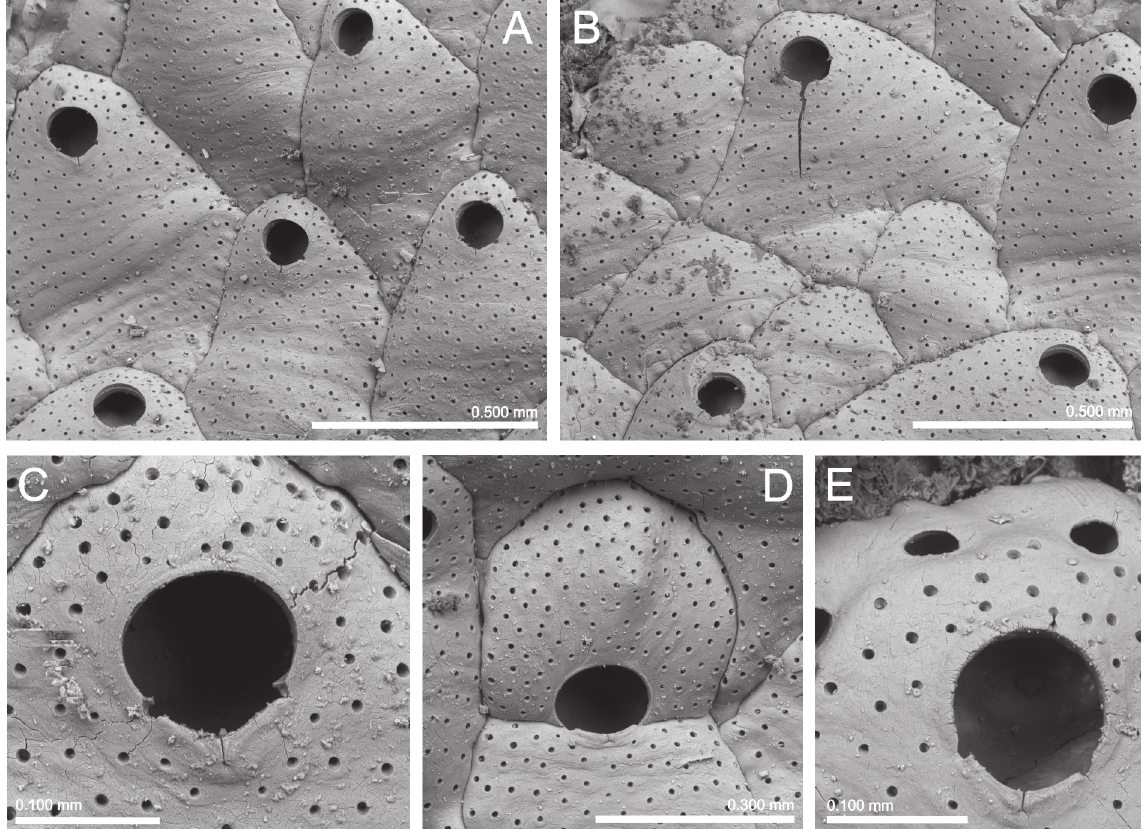
Fig. 1. Lectotype of Hippothoa amoena Jullien & Calvet, 1903 (MOM INV-22578). A . Some autozooids. B . Group of irregular kenozooids. C . Primary orifice. D . Ovicell. E . Distal